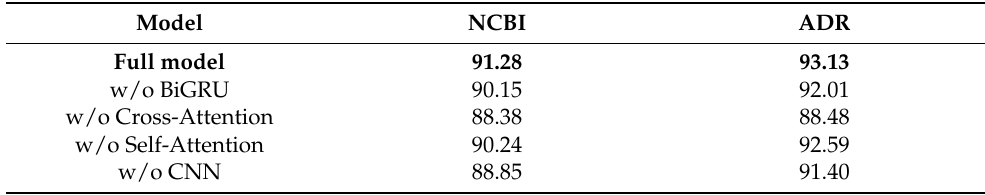
Table 5. Ablation studies of our proposed model on NCBI and ADR test dataset.